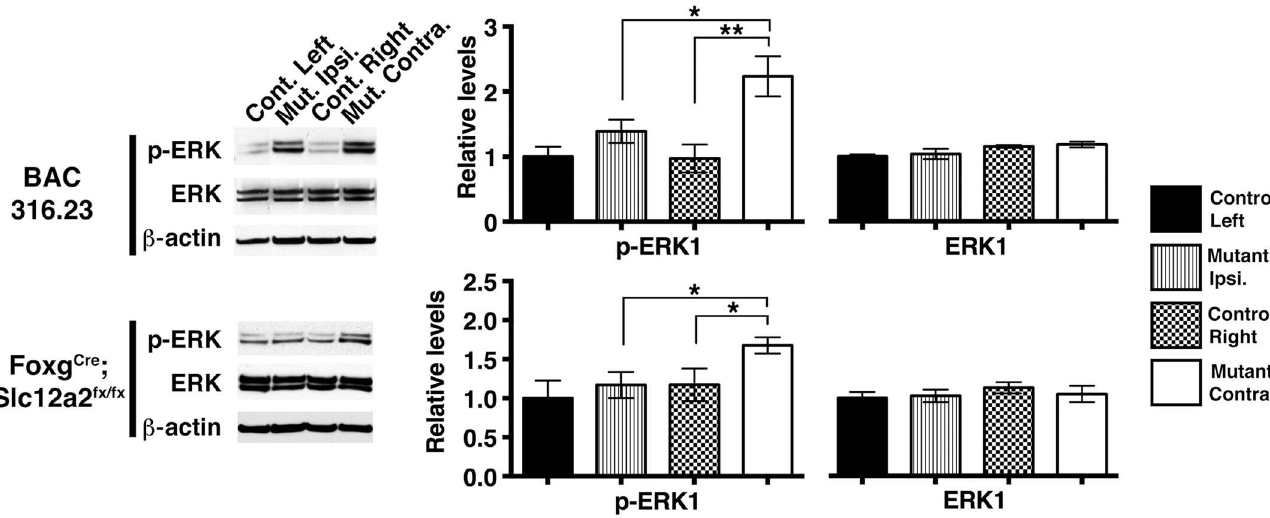
Fig 4. The association between asymmetric striatal p-ERK and the preferred turning direction extends to multiple mouse models of inner ear dysfunction. Western blot analysis and quantification indicate that ERK phosphorylation is up-regulated in the striatal hemisphere contralateral to the preferred direction of signaling in Foxg1 Cre/+ ; Slc12a2 fx/fx (contralateral versus ipsilateral, p = 0.027, n = 6 for mutants and n = 6 for controls) and BAC 316.23 mutants (contralateral versus ipsilateral, p = 0.045, n = 5 for mutants and n = 3 for controls). No significant differences in unphosphorylated ERK were detected between hemispheres in all comparisons. Mean ± SEM, two-tailed t-test. See also S1 Data. BAC, bacterial artificial chromosome; ERK, extracellular signal-regulated kinase; p-ERK, phosphorylated extracellular signal-regulated kinase; SEM, standard error of the mean. (S4A Fig, S1 Data). As hypothesized, adult Slc12a2 K842 (cid:3) /K842 (cid:3) mutants injected with SL327 on